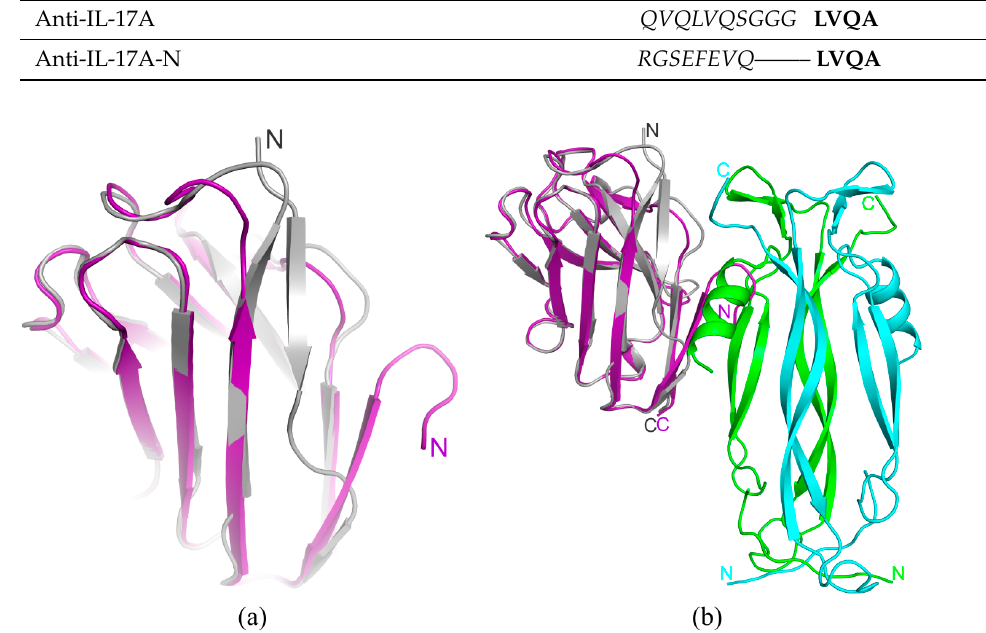
Figure 5. Comparison of anti-IL-17A-76 and anti-IL-17A-N mutant form structures in the free state and in the complex with IL-17A. ( a ) Superposition of the anti-IL-17A-76 (grey) structure from the IL-17A/anti-IL-17A-76 complex and the structure of the anti-IL-17A-N mutant form—purple (PDB code 6RBB). ( b ) Superposition of the anti-IL-17A-N (purple) structure (PDB code 6RBB) on the structure of the anti-IL-17A-76 (grey) in the complex with IL-17A. IL-17A monomers are shown in blue and green. Kinetic analysis of the IL-17A interactions with the anti-IL-17A-76 and with the anti-IL-17A-N showed that the mutant domain affinity did not change. The association and dissociation rate constants are almost the same (Table 4). Table 4. Kinetic constants of the interactions of IL-17A with anti-IL-17A mutant forms.